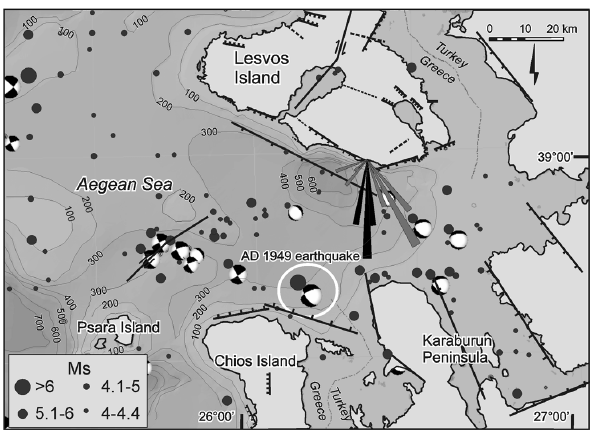
Fig. 6. Epicenter location and focal mechanism of the M s > 4 earthquakes after the 1928 in the study area (data modified from http://naseismic.geo.aegean.gr/). White circle indicates the 1949’s M s = 6.7 event triggering a tsunami wave recorded in Chios and in the Karaburun peninsula. The map also shows the a axis orienta- tion of the larger (black) and smaller (grey) boulders. Faults are modified after Mascle and Martin (1990) and Pavlides et al.